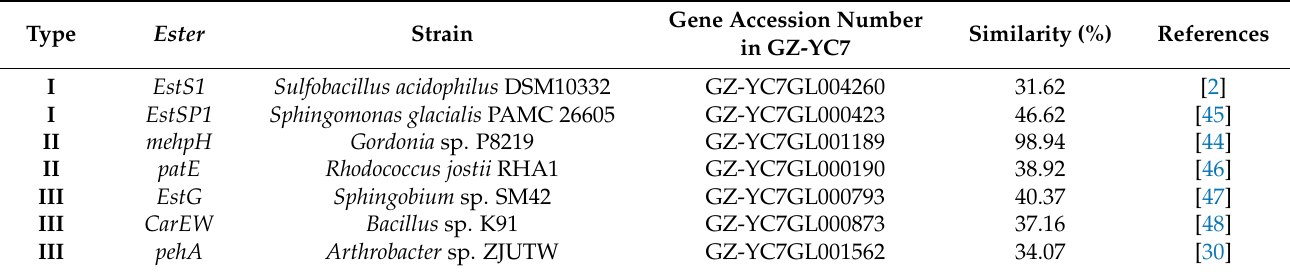
Table 2. Alignment results of esters in Gordonia sp.